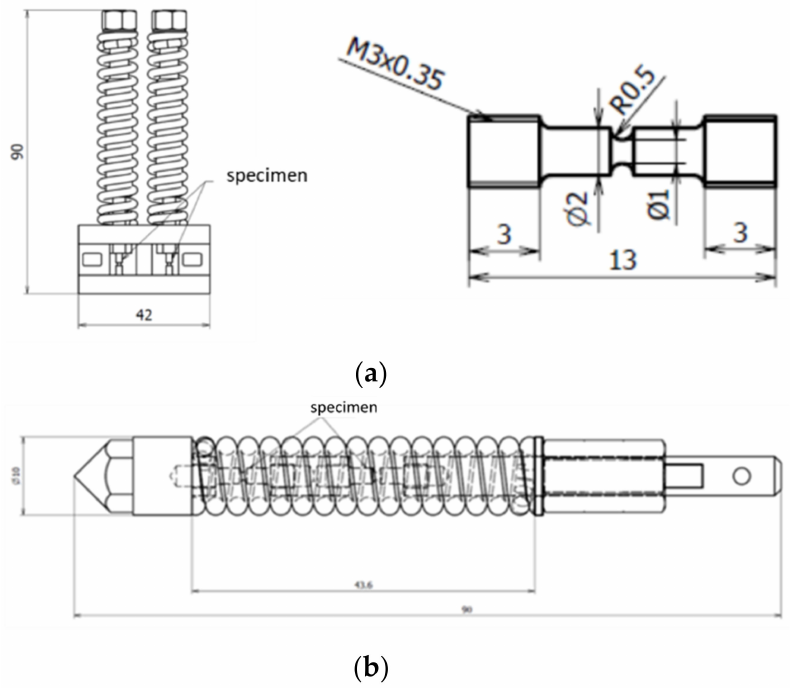
Figure 6. Loading jigs for SCC tests on round notched tensile specimen: ( a ) loading jigs labora- tory tests and geometry and dimension of notched tensile specimen and ( b ) loading jigs for test under